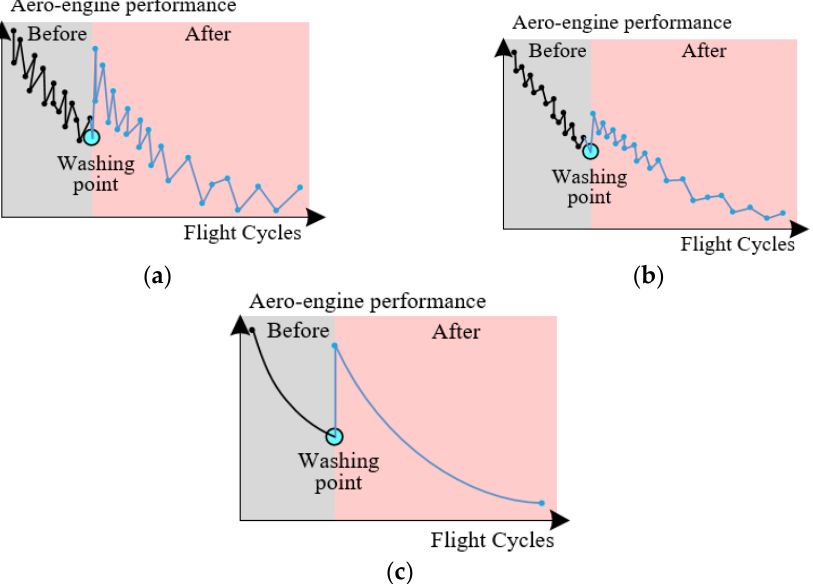
Figure 1. Demand for denoising aeroengine data. ( a ) Raw engine data; ( b ) Denoising effect of traditional methods; ( c ) Denoising required for aircraft engine